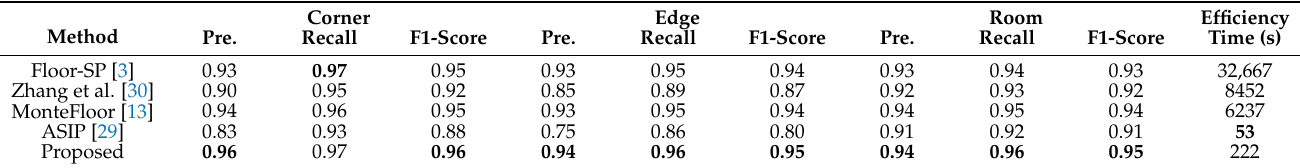
Table 2. Test results for different floorplan reconstruction methods, and the bold values are the best. Corner Edge Efficiency Method